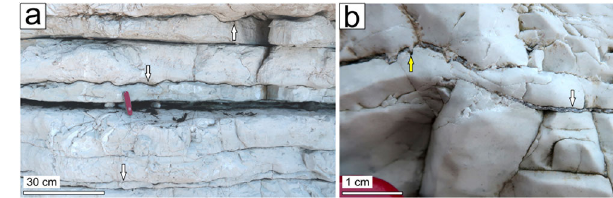
Fig. 1 Examples of macroscopic dissolution structures in outcrop. a Outcrop of the Kaiwhata limestones with fl at-lying beds. White arrows mark large bedding-parallel diagenetic wave-like stylolites. b Close-up cross-sectional view of a horizontal wackestone bed. Dark-grey speckles are detrital grains. The yellow and white arrows mark bedding-internal diagenetic stylolites fi lled with siltstone. The yellow arrow marks a tell-tale stylolite “ tooth ”